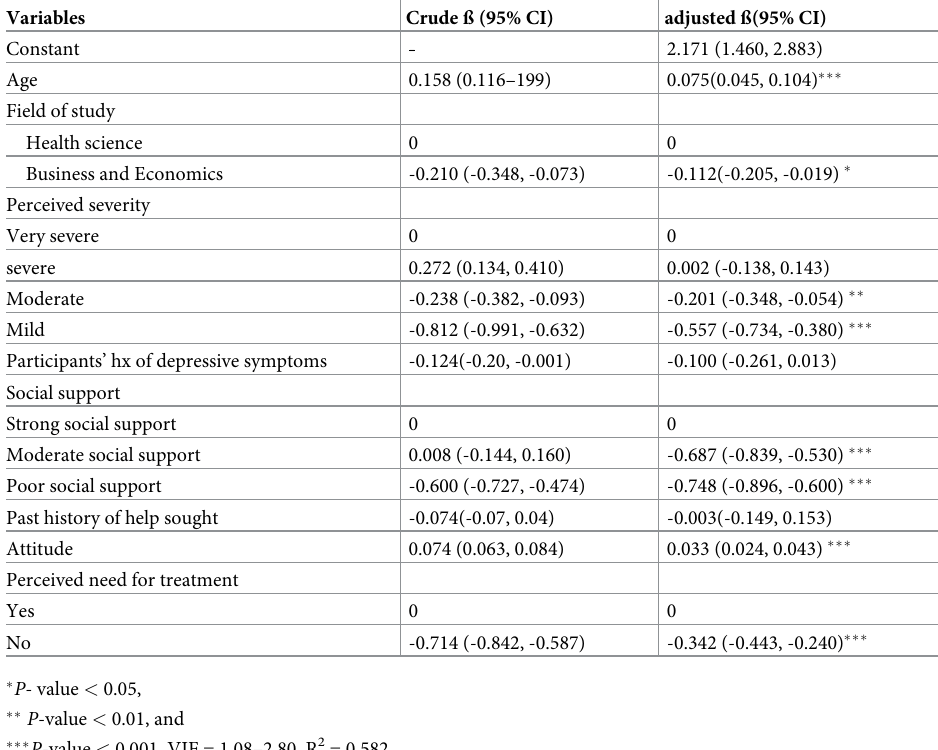
Table 3. Factors associated with help seeking intention for depression from health professionals. Simple and mul- tiple linear regression analysis among University of Gondar students (n =